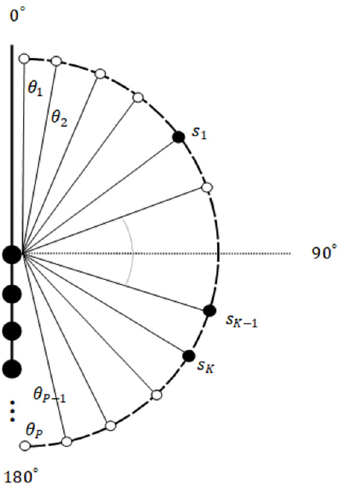
Figure 2. P grid points for narrowband sound sources.